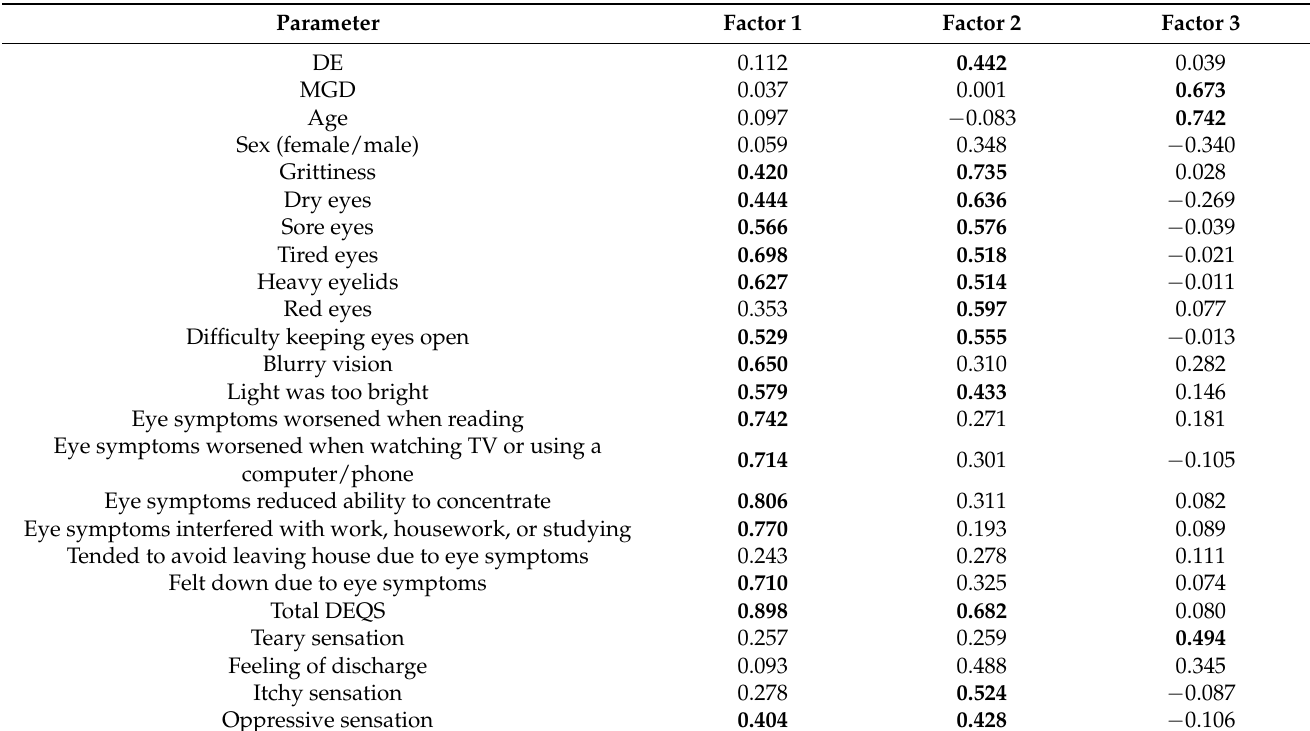
Table 3. Relations among ocular symptoms, dry eye (DE), and meibomian gland dysfunction (MGD) according to Factors 1, 2, and 3,